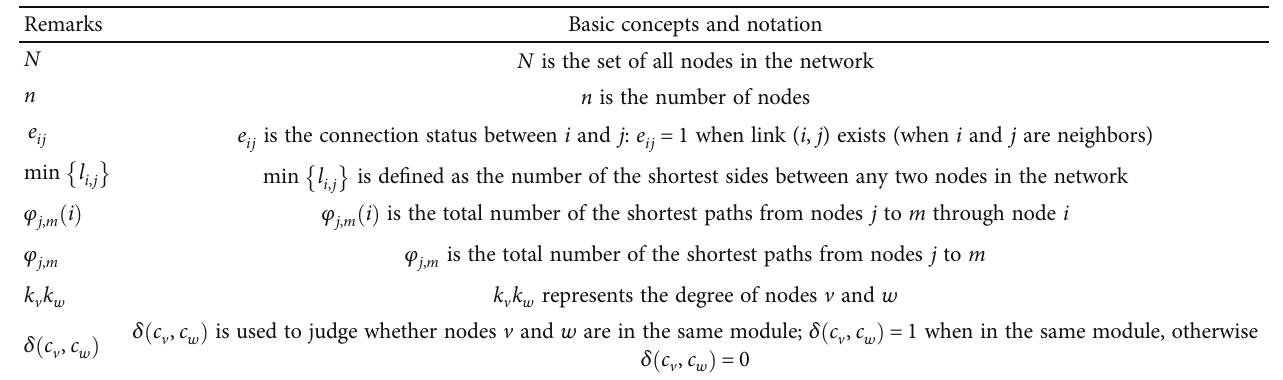
Table 3: Basic concepts and